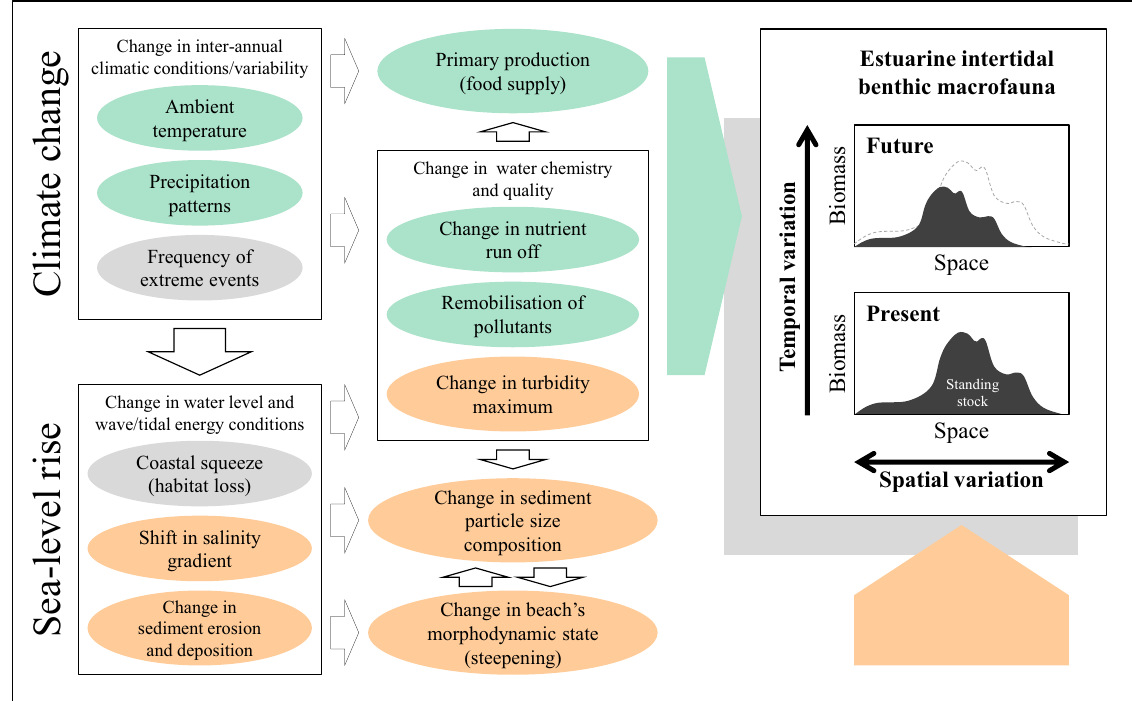
Figure 1. Conceptual representation of inter-relationships within/between broad environmental stressors induced by climate change and sea-level rise and spatio-temporal responses of estuarine intertidal macrobenthic biomass at the estuarine system scale. Stressors with respective pale green, orange and grey background represent environmental drivers which affect variability of macrobenthic biomass: ( 1 ) temporally (pale green); ( 2 ) spatially (orange); ( 3 ) both spatially and temporally